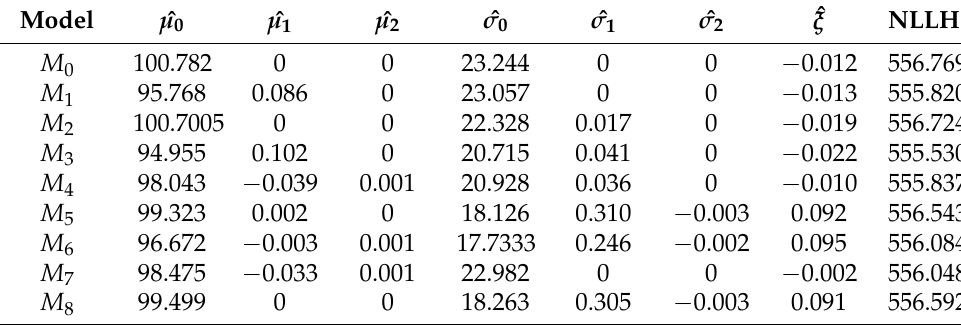
Table 5. Non-stationary GEVD models for Eastern Cape for the period